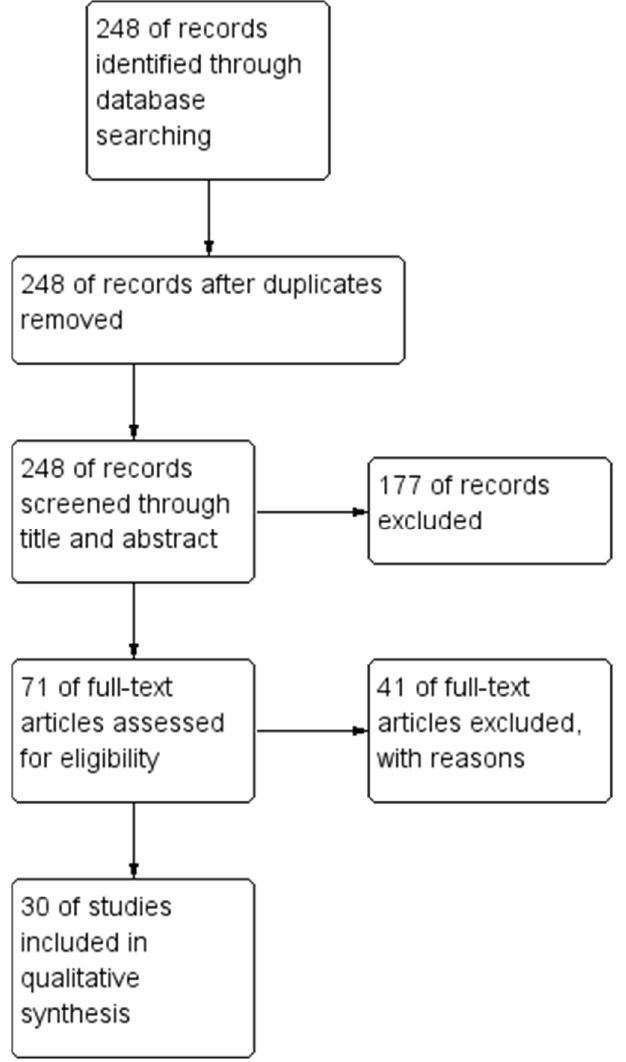
Figure 1 . Study flow diagram . Figure 1. Study flow